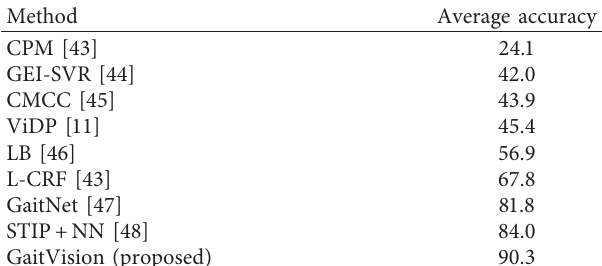
Table 4: Comparison of GaitVision (ours) with the state-of-the-art